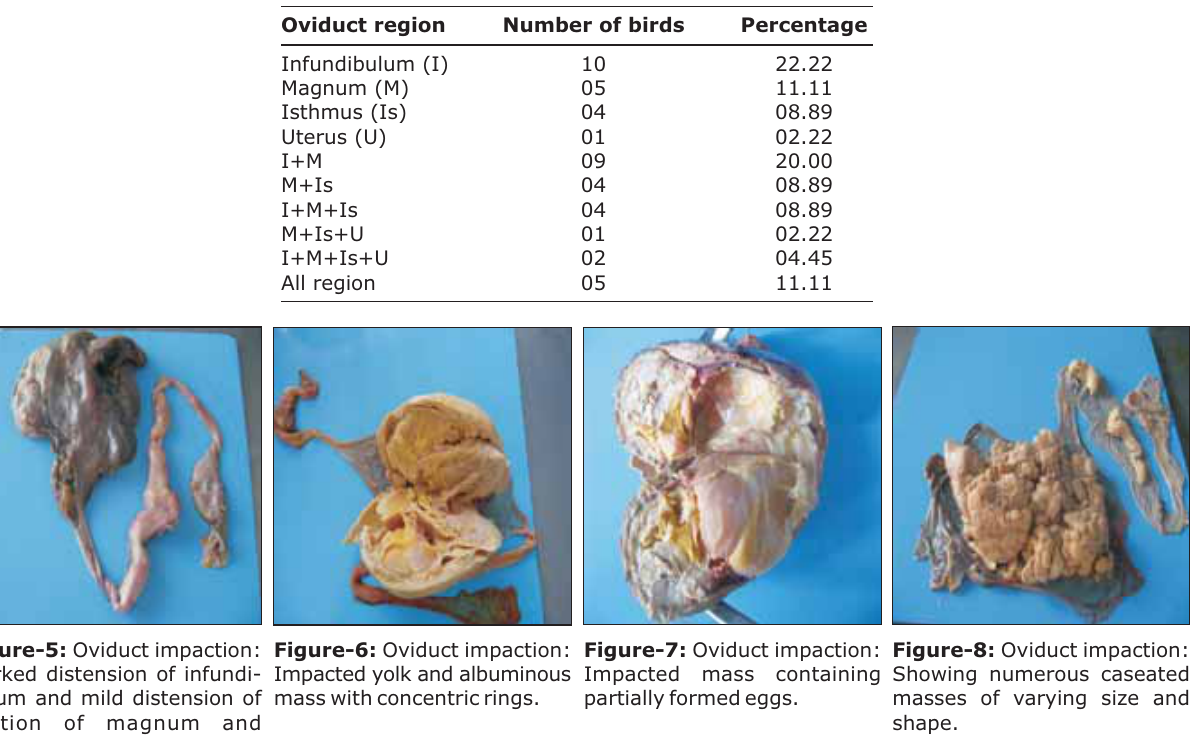
Table-4: Distribution pattern of lesions (%) in various regions of oviduct